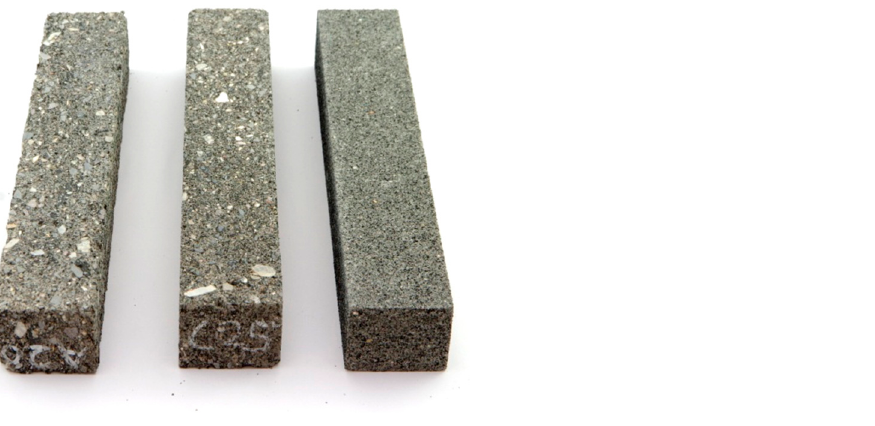
Figure 2. Beams 380 mm × 63 mm × 50 mm of ACC with “B” mortar, and “B” CSR mortar alone for testing the stiffness modulus using 4PB-PR method.